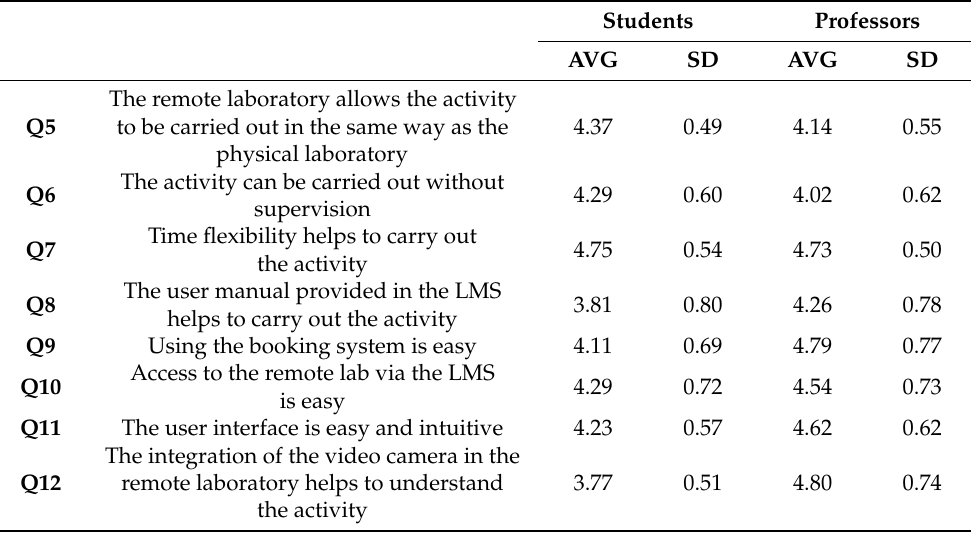
Table 8. Usability perceived by students and